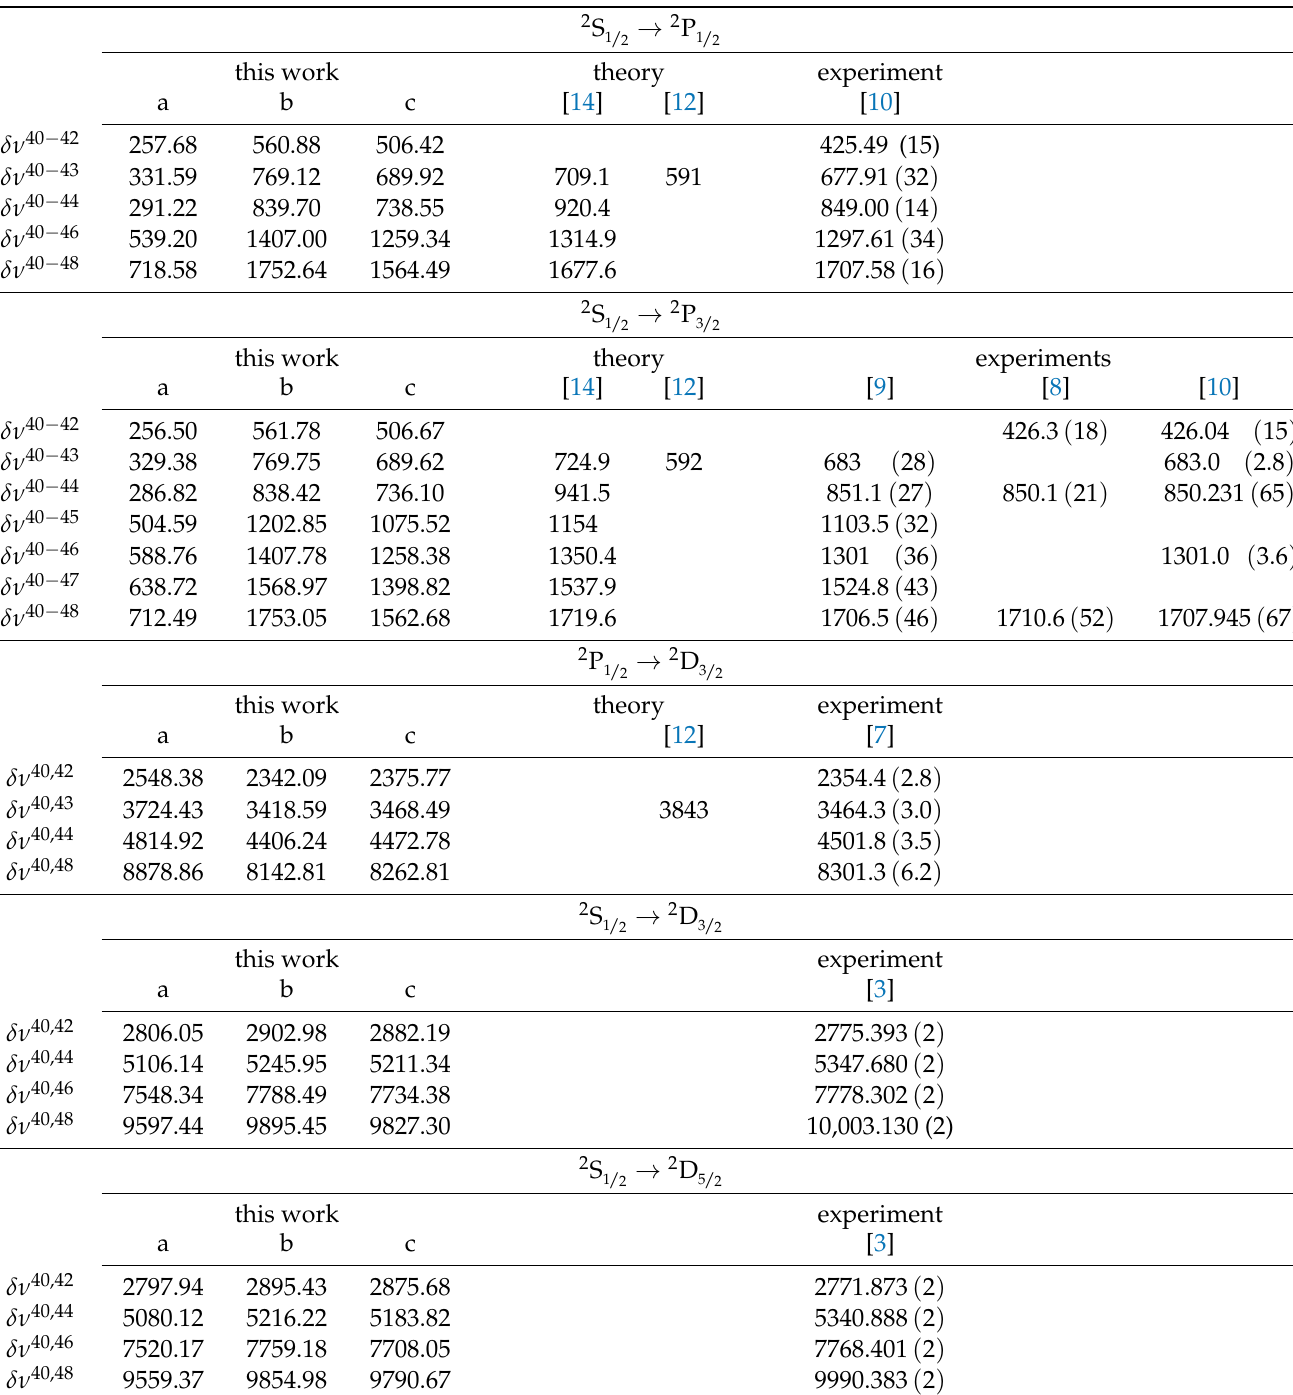
Table 4. Derived isotope shifts for a series of isotopes, using 40 Ca as reference, for the dipole allowed transitions 2 S 2 S → 2 P → 2 D , and 2 P as well as for the 2 S 1 / 2 3 / 2 1 / 2 3 / 2 compared to other theoretical works and experiments. The columns are labelled as in Table